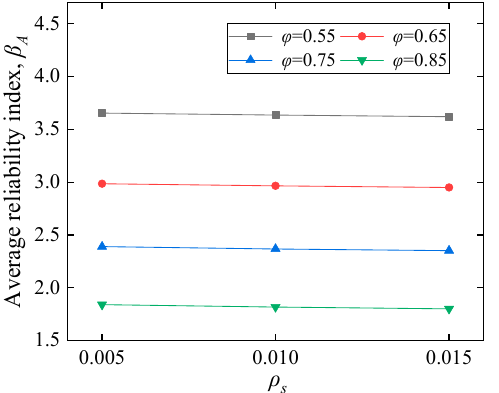
Figure 11. Steel reinforcement ratio effects.